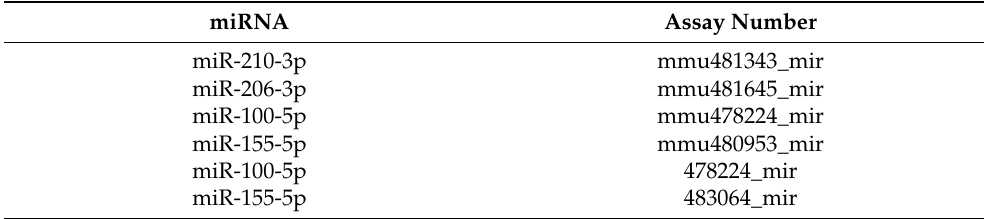
Table 1. List of TaqMan probes used to detect miRNA